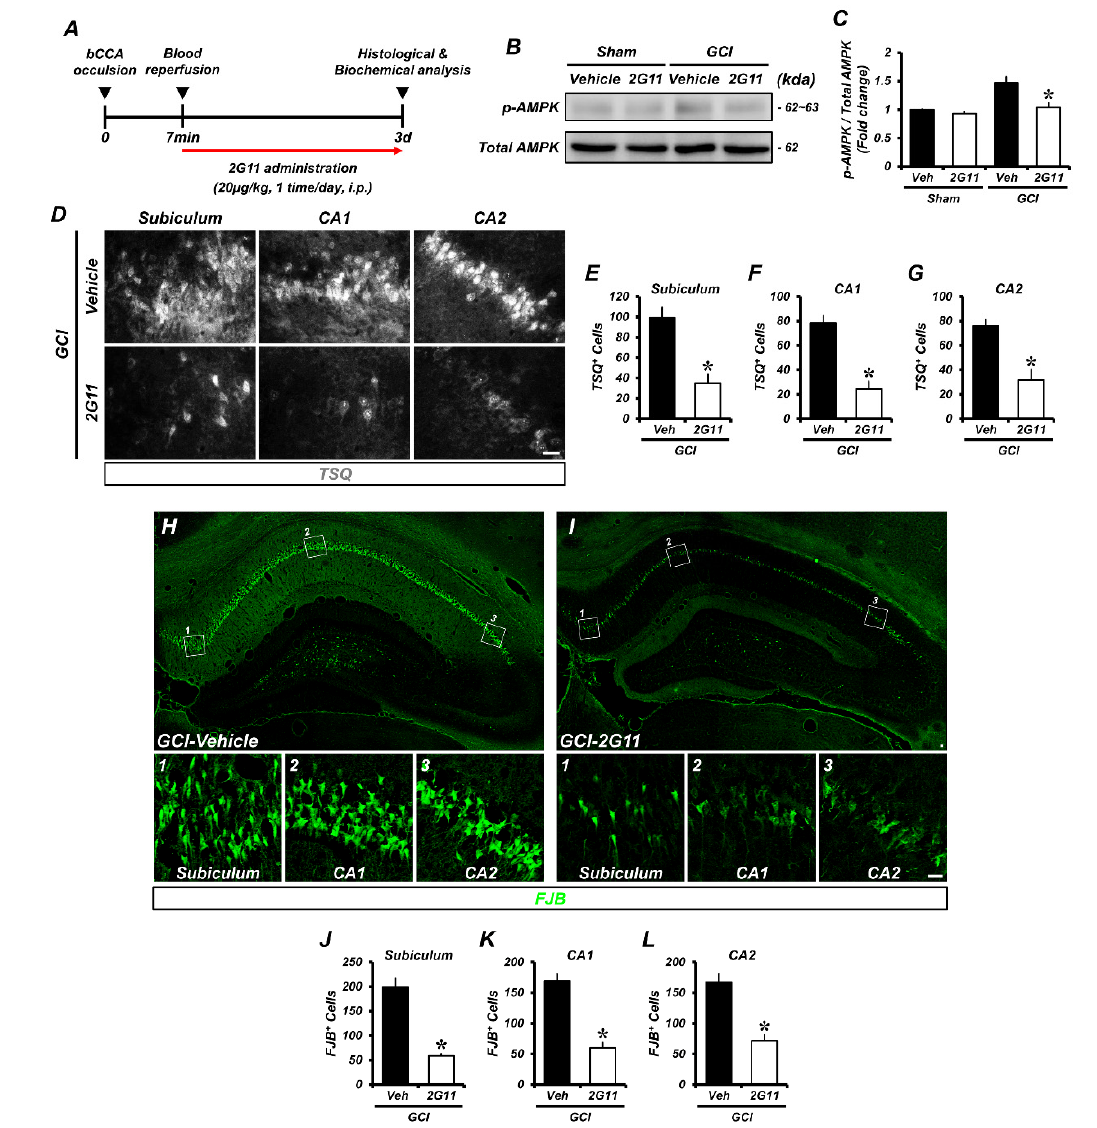
Figure 2. The 2G11 treatment reduced intracellular zinc accumulation, AMPK phosphorylation, and neuronal death after GCI. ( A ) Timeline displaying the experimental design. 2G11 was intraperito- neally administered once per day for 3 days before animal sacrifice. Rats were then killed 3 days after GCI. ( B ) Western blot analysis of p-AMPK (T183( α -1)/T172( α -2)) and total AMPK in the hip- pocampus after the sham surgery or GCI. ( C ) Western blot analysis of p-AMPK protein levels from the hippocampus. Data are the mean ± SEM ( n = 3 from each sham group, n = 8 from each GCI group). * p < 0.05 vs. the vehicle-treated GCI group (Kruskal–Wallis test followed by a Bonferroni post-hoc test: chi square = 10.869, df = 3, p = 0.012). ( D ) Representative images showing sections of the hippocampal subiculum, CA1, and CA2 stained with TSQ to detect intracellular zinc accumula- tion. Scale bar = 25 μ m. ( E – G ) Quantification of the number of TSQ + cells from the hippocampal subiculum, CA1, and CA2 regions. Data are the mean ± SEM; n = 6 from each group, * p < 0.05 vs. the vehicle-treated GCI group (Mann–Whitney U test: z = 2.882, p = 0.002). ( H , I ) Representative im- ages of degenerating neurons (FJB; green) in the subiculum, CA1, and CA2 from the hippocampus of the vehicle- and 2G11-treated groups after GCI. Scale bar = 20 μ m. ( J – L ) Quantification of the number of FJB-positive cells from the hippocampal subiculum, CA1, and CA2 areas. Data are the mean ± SEM; n = 4 from each group, * p < 0.05 vs. the vehicle-treated GCI group (Mann–Whitney U test, subiculum: z = 2.309, p = 0.029; CA1: z = 2.309, p = 0.029; CA2: z = 2.309, p = 0.029).